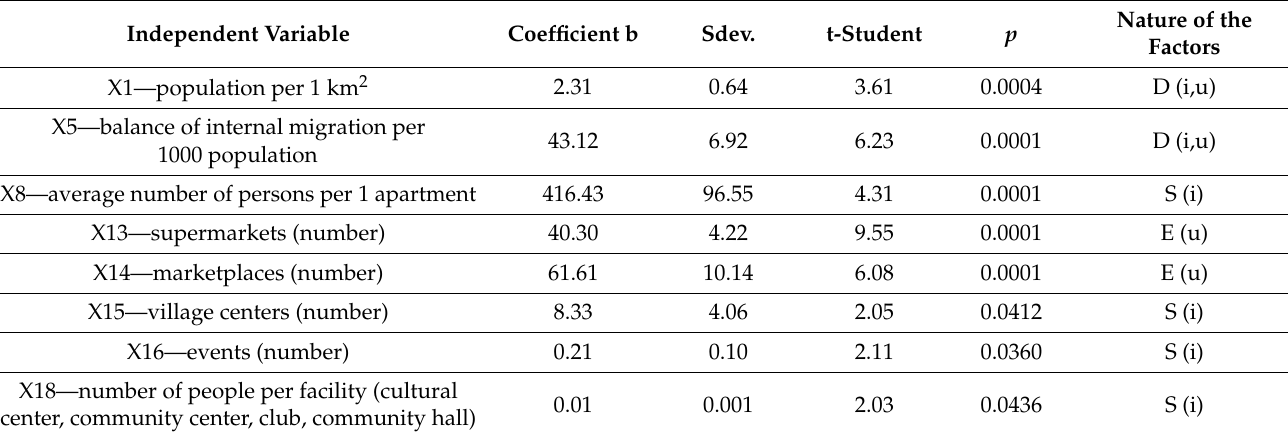
Table 3. Modeling results for determining